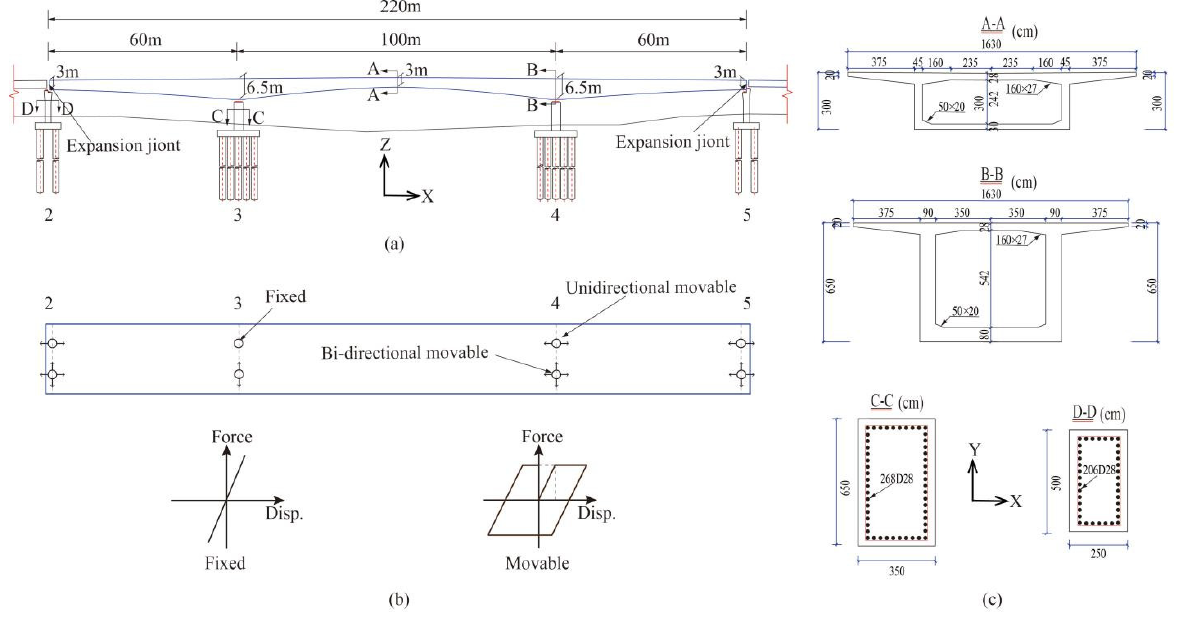
Figure 6. Description of the girder bridge: ( a ) elevation and ( b ) plan of the prototype bridge and ( c ) section properties.